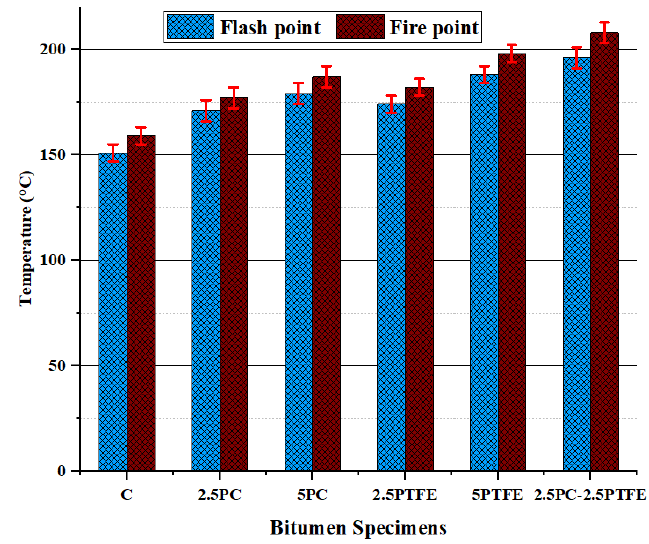
Figure 3. Flash and fire point temperature values of binders.